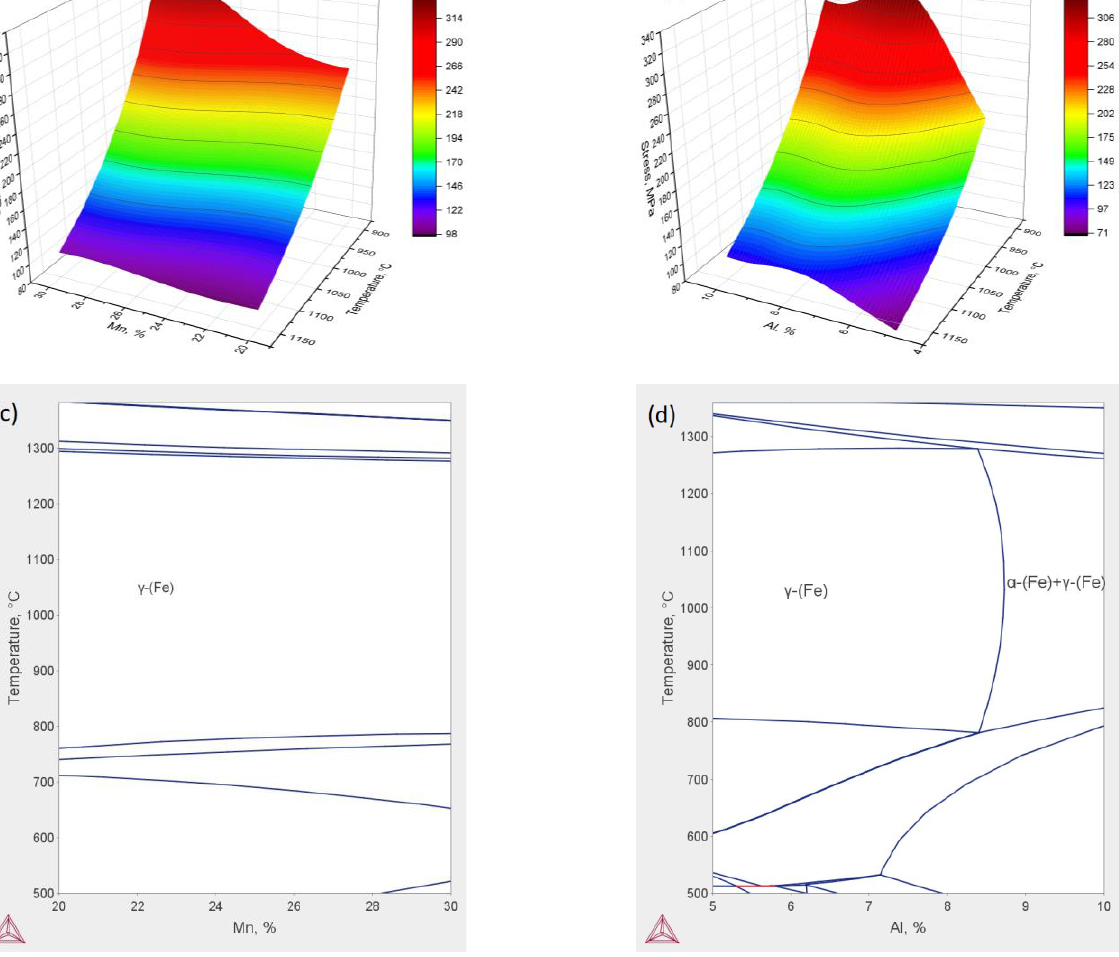
Figure 7. Calculated dependence of the true stress on the temperature and Mn ( a ) and Al ( b ) contents at a strain rate of 1 s − 1 and a true strain of 0.7. The phase diagrams of the Fe–xMn–8Al–1C ( c ) and Fe–28Mn–xAl–1C ( d ).